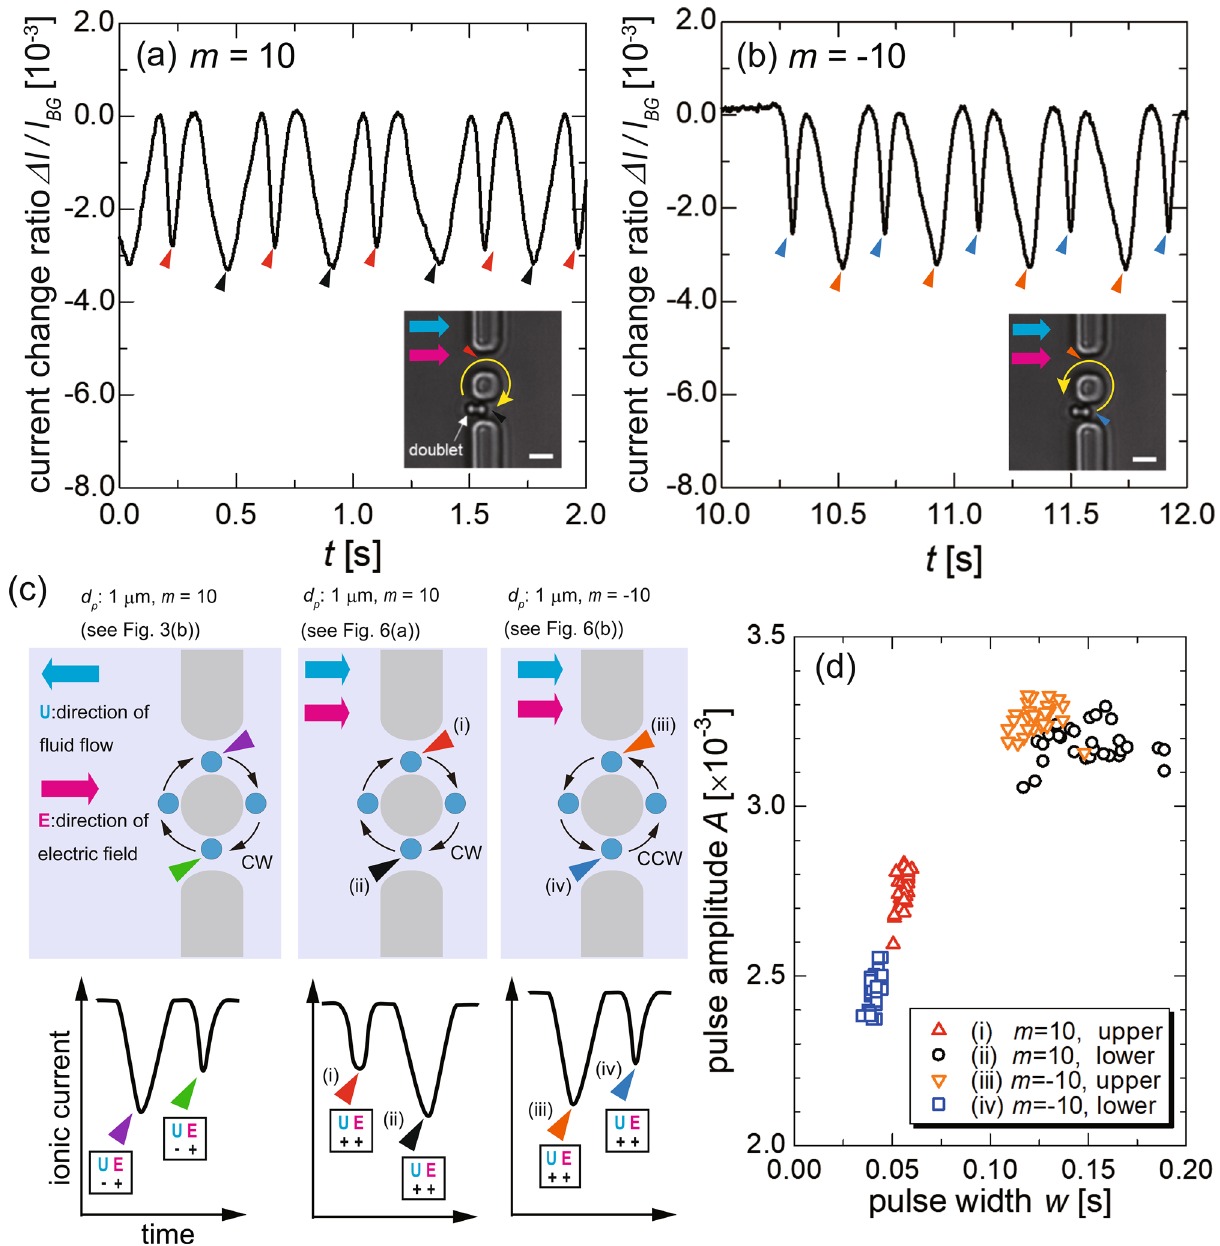
10 Figure 6. Resistive-pulse waveforms of the particle translocation driven by the LG beam with ( a ) m = 10 . The ionic current is acquired with an applied voltage of 0.3 V. Insets show the appearance of the and ( b ) − orbital motion in the double orifice. The blue, magenta, and yellow arrows represent the direction of the fluid flow, electric field, and orbital motion, respectively. The scale bars denote 3 µ m. ( c ) Schematic summary of the relationship between the directions of the particle motion, electric field, and fluid flow, and the resistive- pulse waveforms. U and E denote the direction of fluid flow and electric field in the orifice, respectively. Here, ) . The abbreviations CW and CCW in the figure the vector in a direction from left to light is defined as ( + correspond to the rotation direction of the orbital motion being clockwise and counterclockwise, respectively. Here, it should be noted that the directions and velocities of the pressure-driven flow were uncontrolled, randomly changed for individual experiments, but were unchanged during the experiment. ( d ) Relationship between the pulse width and amplitude for a particle doublet. Note that the data for the 1- µ m single particle are not plotted on this figure, because the absolute values of pulse width and amplitude were very far from the plotted region. Each plot color corresponds to the arrowheads in ( c ). The results indicate that a faster orifice translocation leads to a smaller pulse amplitude based on a change in the relative velocity between the particle motion and fluid